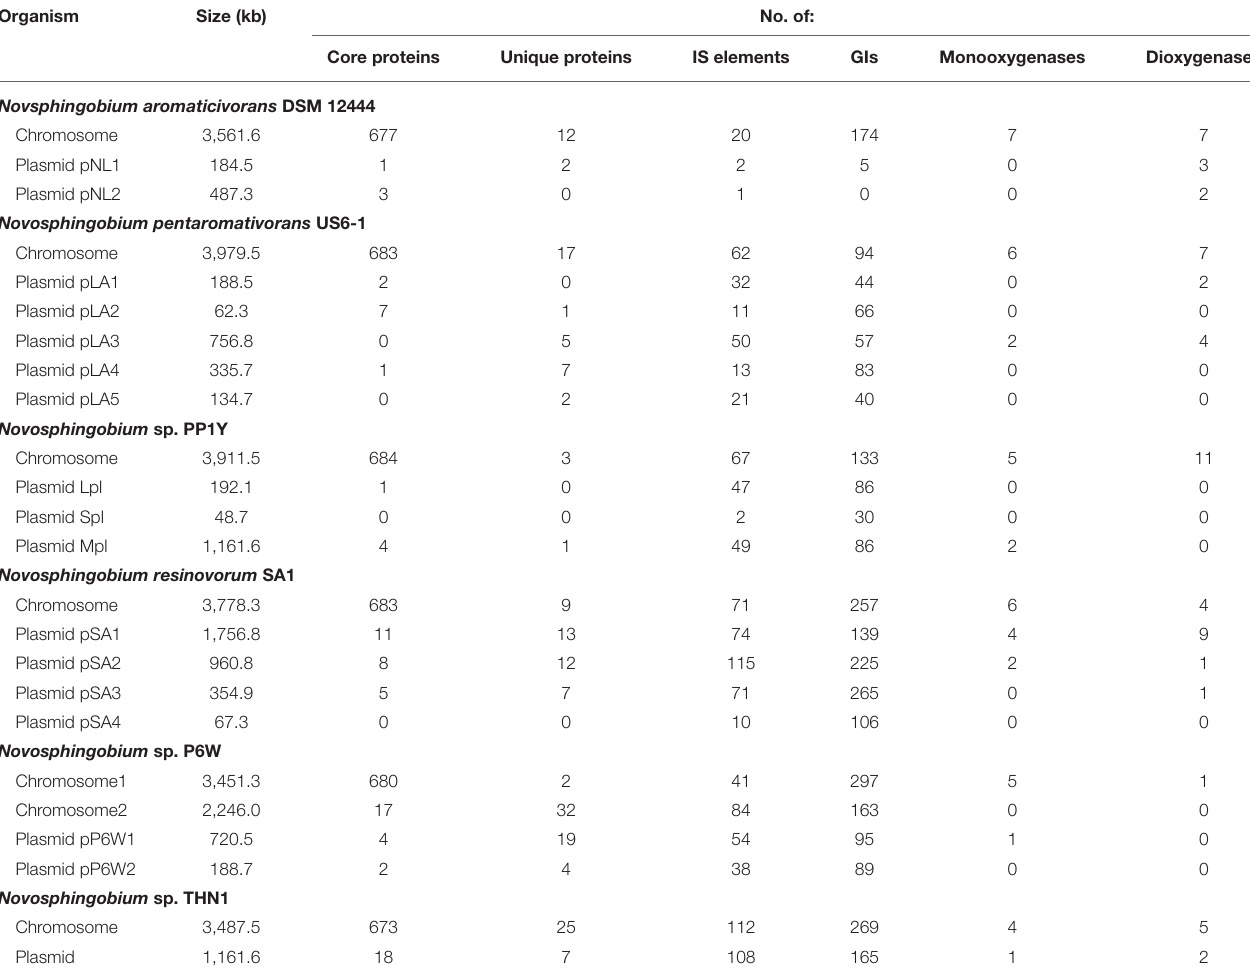
TABLE 2 | Size and number of genetic elements and biodegradative enzymes in the six complete Novosphingobium genomes. Organism Size (kb) No. of: Core proteins Unique proteins IS elements GIs Monooxygenases